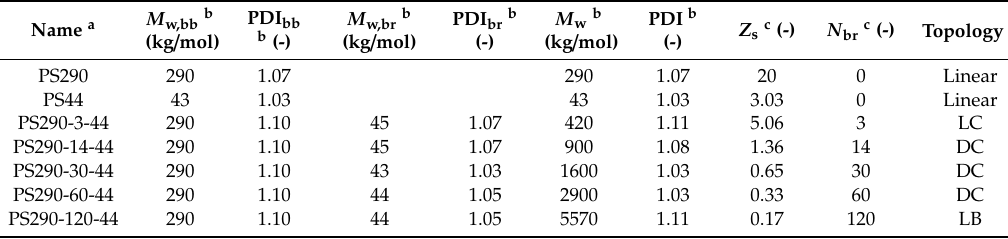
Table 1. Molecular characteristics of model comb polystyrene (PS)